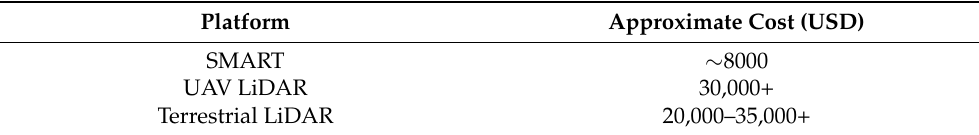
Table 11. Cost comparison of LiDAR-based stockpile mapping